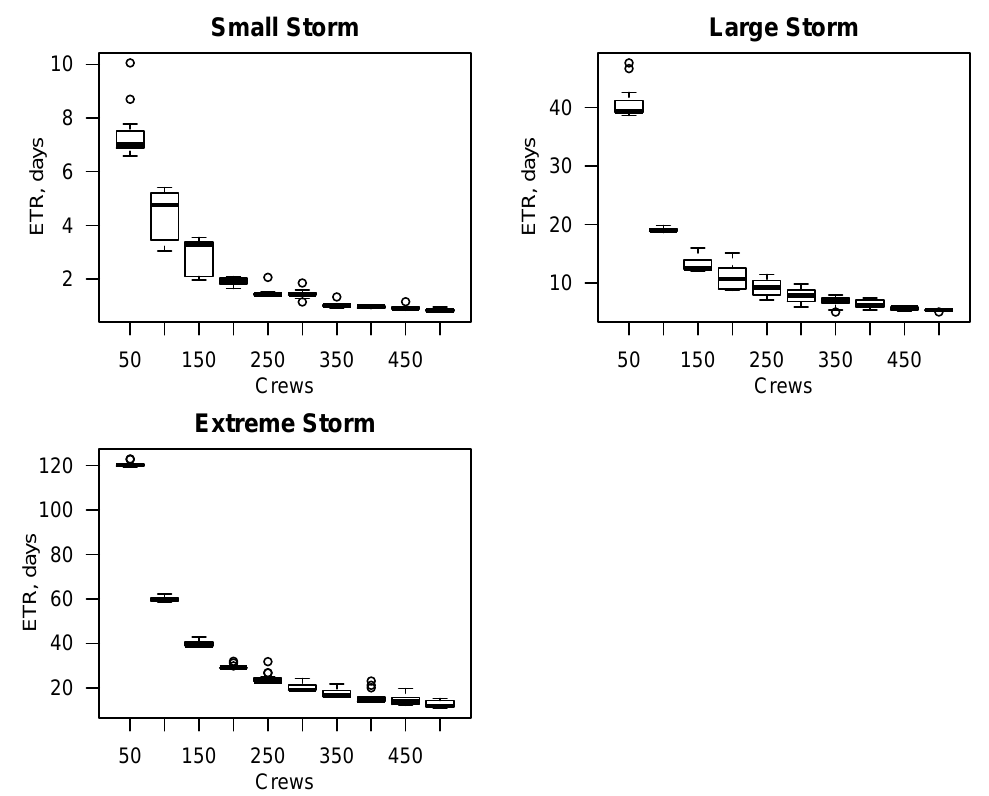
Figure 11. Changing number of crews for large and extreme storm. Crew start location set to area work center and search strategy set to nearest outage. Travel speed set to 25 mph. 85% crews working during day shift, 99% working during evening shift and 66% working during night shift, 1 to 10 h repair time range. 1000 outages for small storm, 5000 outages for large storm, 15,000 outages for extreme storm. Increasing the number of crews decreases ETR until a threshold, which varies by storm